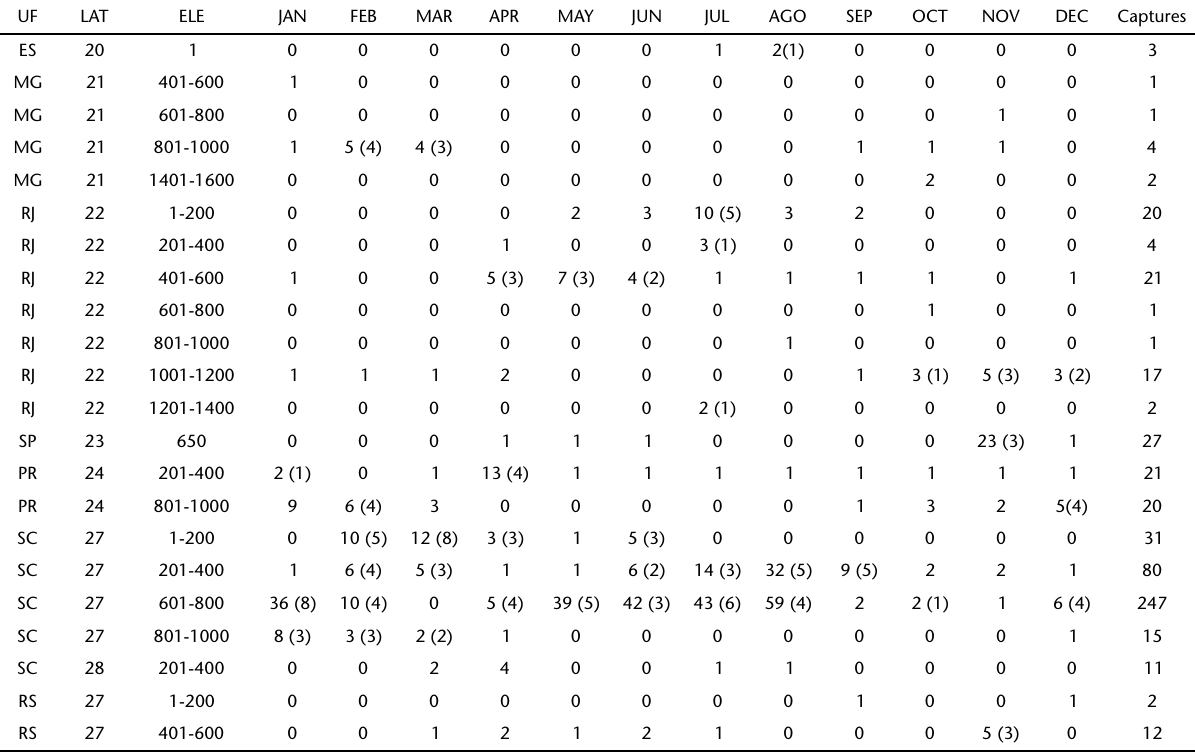
Table II. Captures of Pygoderma bilabiatum in the states (UF) of Espírito Santo, Minas Gerais, Rio de Janeiro, São Paulo, Paraná, Santa Catarina, and Rio Grande do Sul, according to month and elevation. Latitude (LAT) is given in degrees and elevation (ELE) in meters above sea level. Numbers in parentheses represent the number of nights in which the species was captured, when it differed from the total of